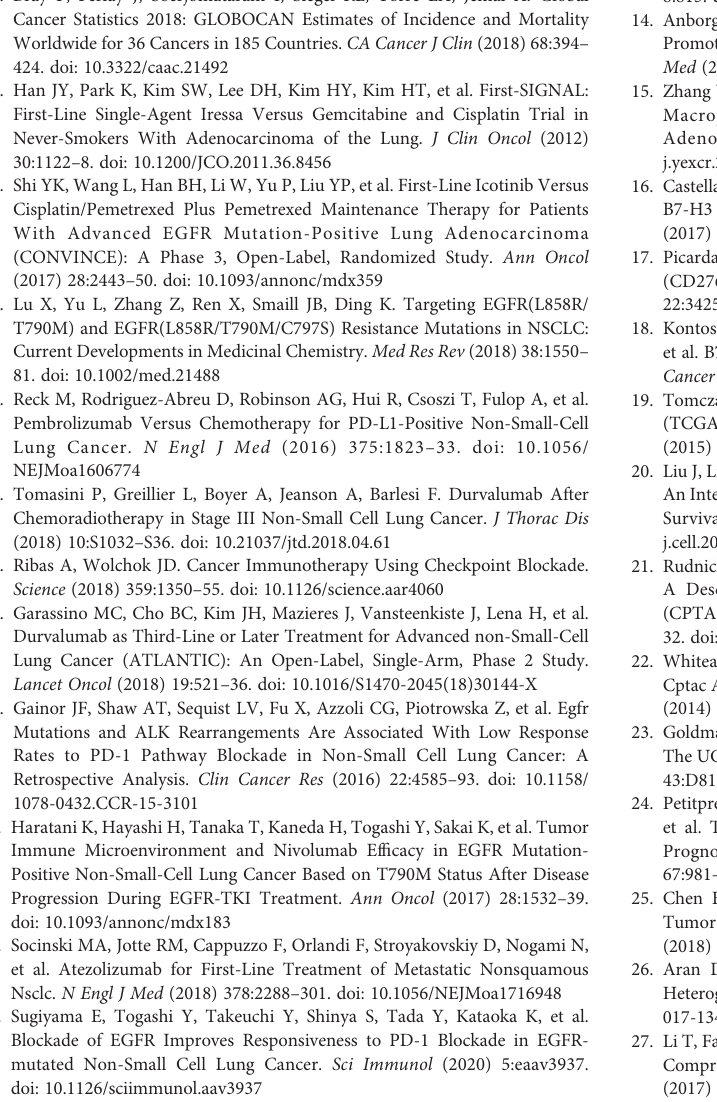
comparison ofEGFR wild-typeand mutant patients inSPP1high expressiongroup. (B) Prognosis comparison of EGFR wild-type and mutant patients in SPP1 low expression group. Supplementary Figure 2 | CD8+ T cells and M2 macrophage differed between groups with high SPP1 expression and EGFR mutation and those with low SPP1 expression and wild-type EGFR. (A) Differences in CD8+ T cells in fi ltration calculated by CIBERSORT between SPP1 high-expression with EGFR mutation and SPP1 low-expression with EGFR wild type. (B) Differences in M2 macrophages in fi ltration calculated by CIBERSORT between SPP1 high-expression with EGFR mutation and SPP1 low-expression with EGFR wild type. (C) The difference in CD8+ T cells abundance assessed by xCell was compared between the group of SPP1 high-expression with EGFR mutation and SPP1 low-expression with EGFR wild type samples. (D) The difference in M2 macrophage abundance assessed